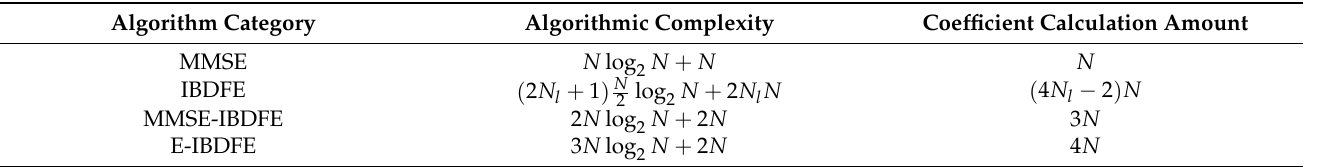
Table 1. Comparison of complexity.